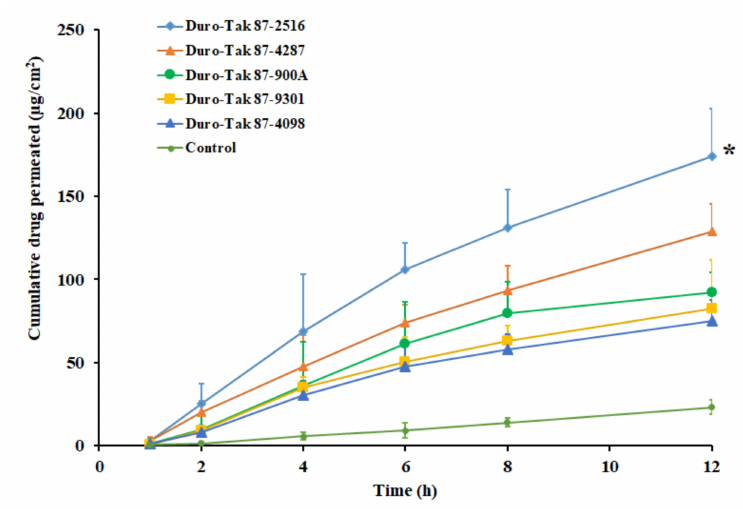
Figure 2. Amount of drug permeated across the rat skin membrane at di ff erent time intervals from various acrylic pressure sensitive adhesive pioglitazone (2% w / w ) patches. All values are mean ± SD ( n = 6). The profile of DIA patch prepared using Duro-Tak 87-2516 adhesive is statistically (*) di ff erent ( p < 0.05) when compared to other adhesives tested. Table 3. Ex vivo permeation parameters observed in various